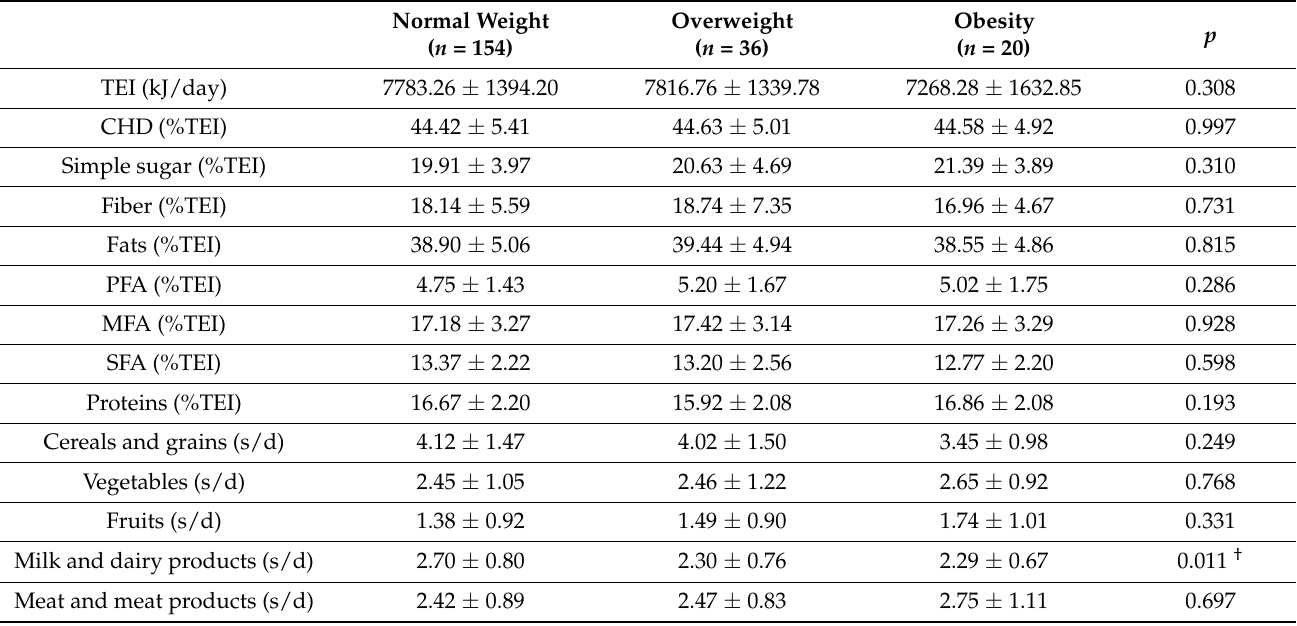
Table 2. Main diet characteristics of the schoolchildren in accordance with nutritional status (IOTF